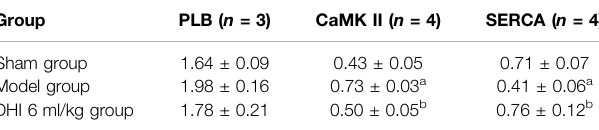
TABLE 5 | Effect of DHI on myocardial protein expression in rats with AMI ( (cid:1) x ±s).